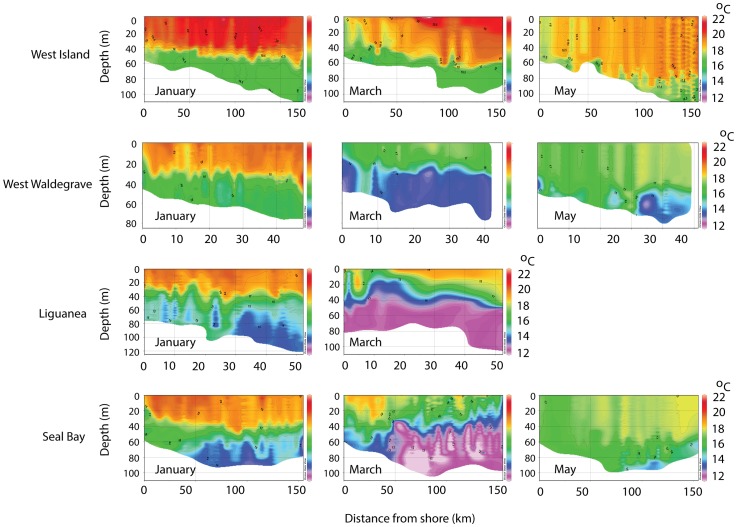
Temporal changes in water column thermal structure throughout the study range derived from CTD profile data.Water depth (m) and perpendicular distance from shore (km) are represented on the X and Y axes, respectively. Cross-sectional water temperature profiles demonstrate thermal stratification both at and among sites, with the onset of the eastward-flowing Leeuwin Current leading to almost complete mixing by May and signifying the end of summer upwelling. Truncation of the data from the Liguanea male is due to the CTD ceasing transmission at the end of March. Similar variability in mixed layer and haline structuring was observed over the same period (not shown). The reduced number of sites and bi-monthly representation are intended purely to reduce figure complexity while still capturing the temporal and geographical extent of oceanographic variability.